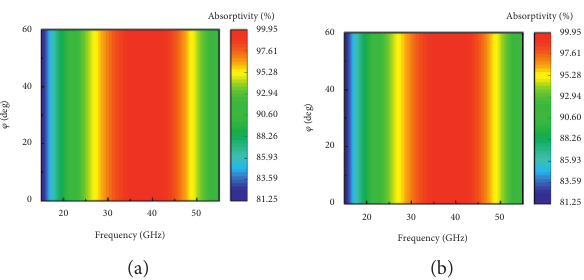
Figure 6: Absorptivity in TE and TM polarizations at different polarizing angle: (a) TE polarization and (b) TM